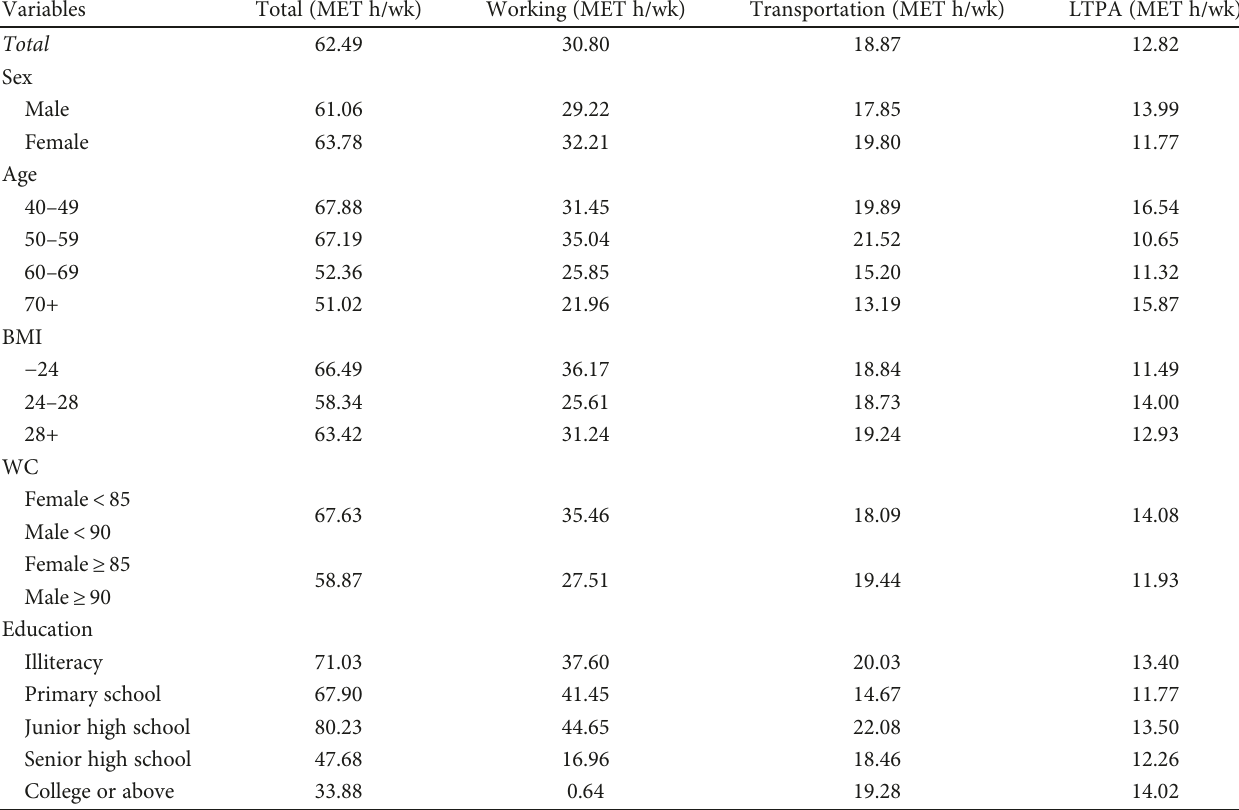
Table 2: The physical activity levels in di ff erent domains of the participants grouped by di ff erent factors.